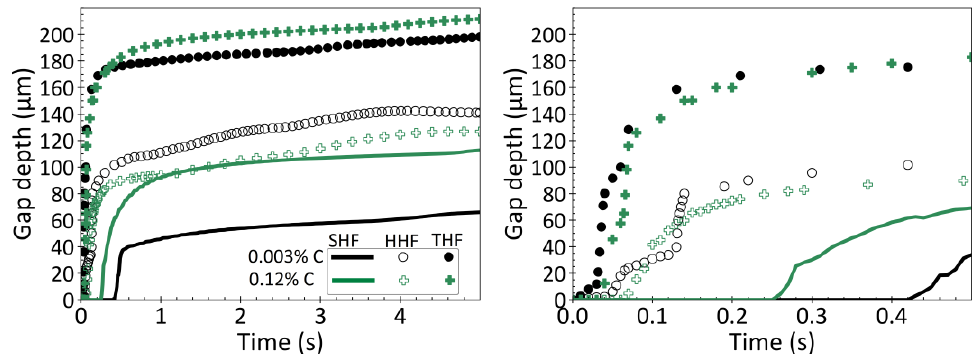
Figure 10. Gap depth evolution with time, comparing steels with 0.003%C and 0.12%C at different heat fluxes.